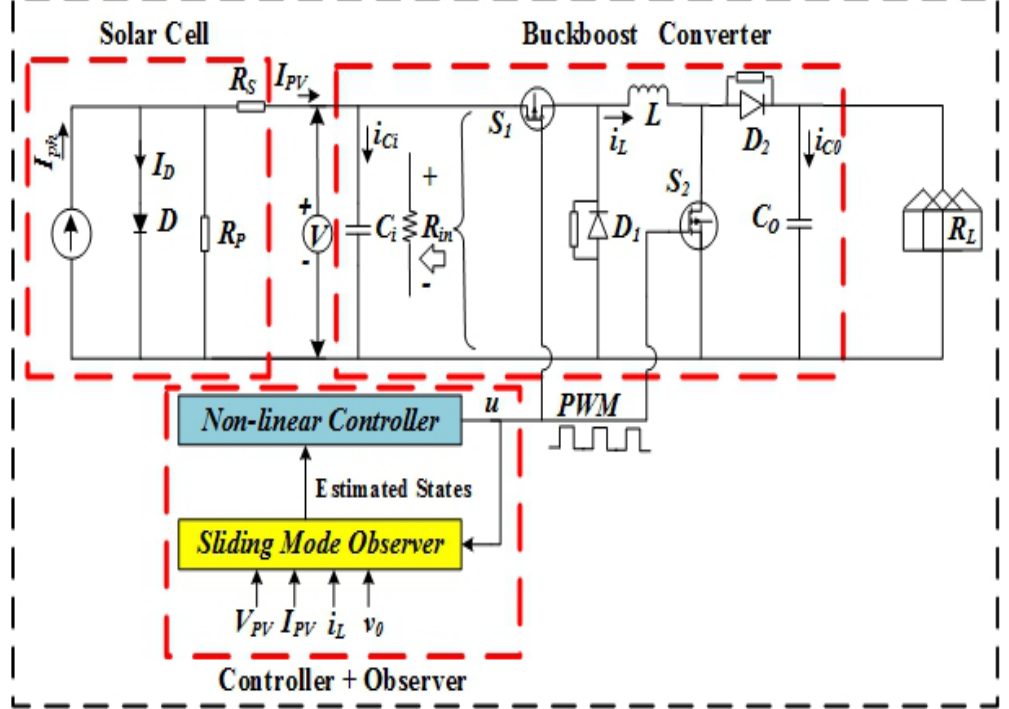
Figure 2. A complete PV model with a variable resistive load and an